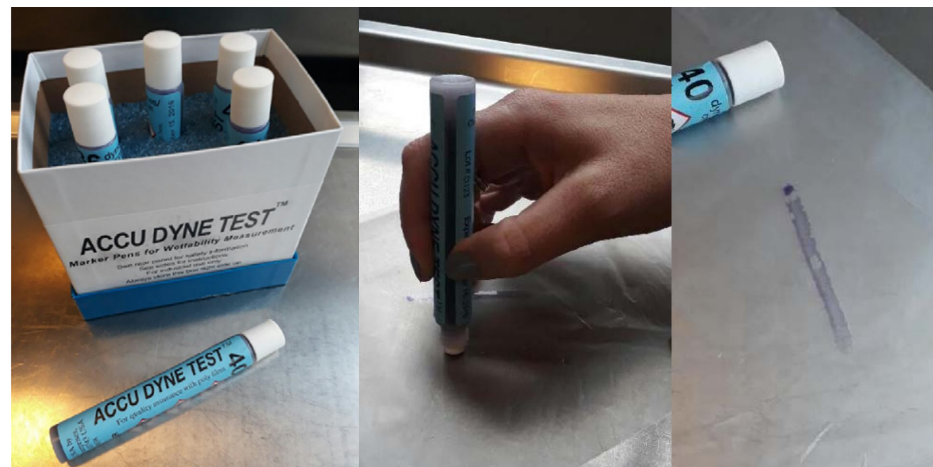
Figure 7. Accu Dyne TestTM pen.